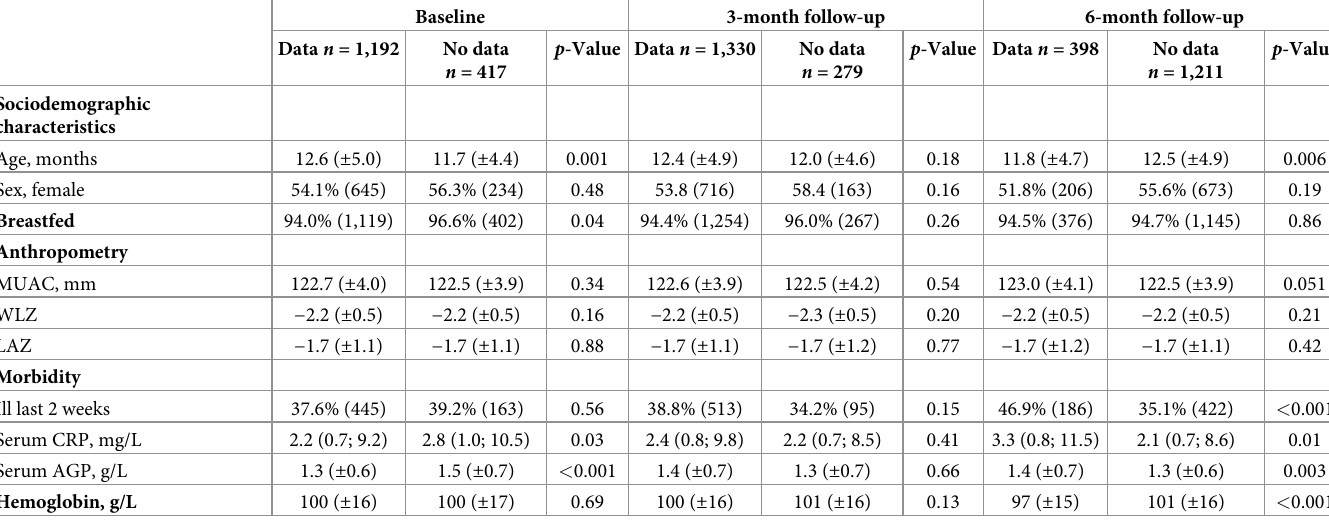
Table 1. Baseline characteristics of 1,609 children with MAM with or without cobalamin data at baseline and 3- and 6-month follow-up. Baseline 3-month follow-up 6-month follow-up Data n = 1,192 No data p -Value Data n = 1,330 No data p -Value Data n = 398 No data p n = 417 n = 279 n = 1,211